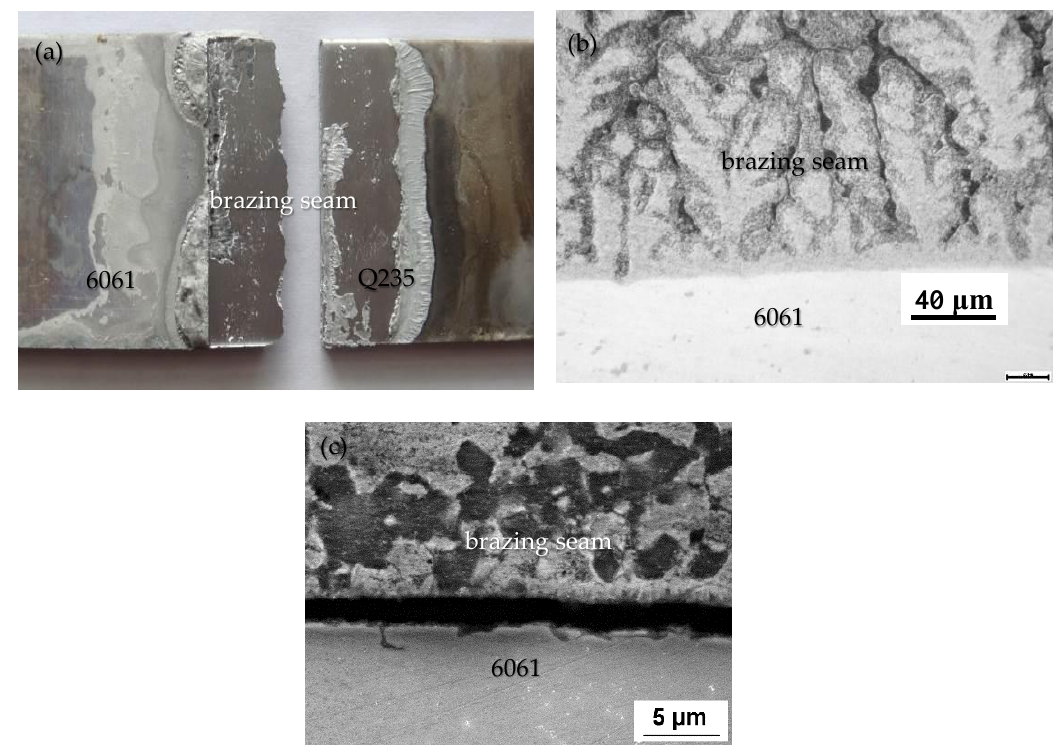
Figure 6. Typical fracture modes of 6061/Q235 brazed joints: ( a ) Macromorphology of fracture interface; ( b ) Organization of interface before shear tests; ( c ) Microtopography of fracture interface after shear tests.